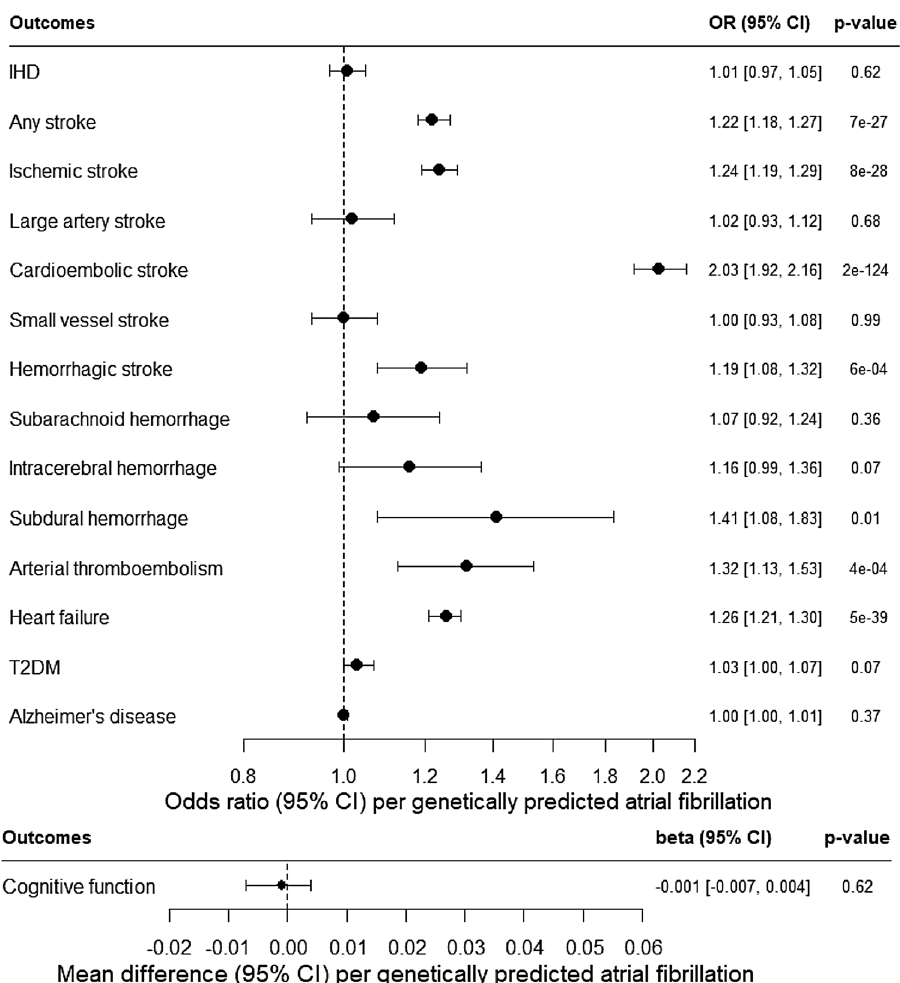
Figure 1. Association of genetically predicted atrial fibrillation with ischemic heart disease (IHD), stroke, arterial thromboembolism, heart failure, type 2 diabetes (T2DM), cognitive function, and late-onset Alzheimer’s disease (AD) based on estimates from inverse variance weighting (IVW) using Mendelian randomization